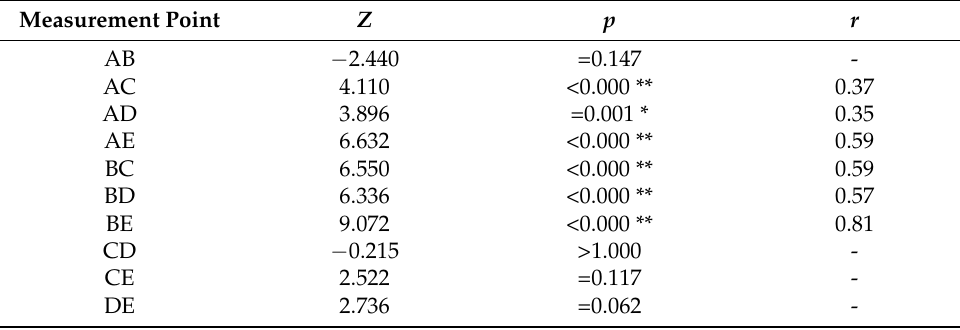
Table A5. Ceramic 4y_PM ( χ 2 (4) = 104.5; p < 0.000); N =